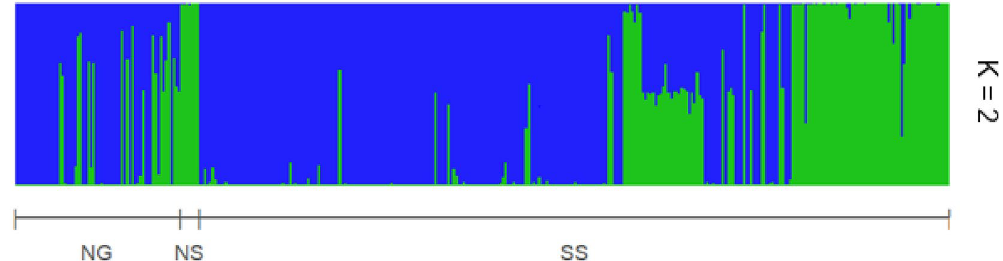
Figure 1. Structure diagram showing the delineation of Kersting’s groundnut individuals into two genetic populations (K = 2), Pop1 (Blue) and Pop2 (Green). Vertical lines represent individuals within populations and those with more than one color share genetic information with other populations. The horizontal line shows the distribution of the populations across agroclimatic zones (Northern-Guinean NG, Northern-Sudanian NS, and Southern-Sudanian SS).